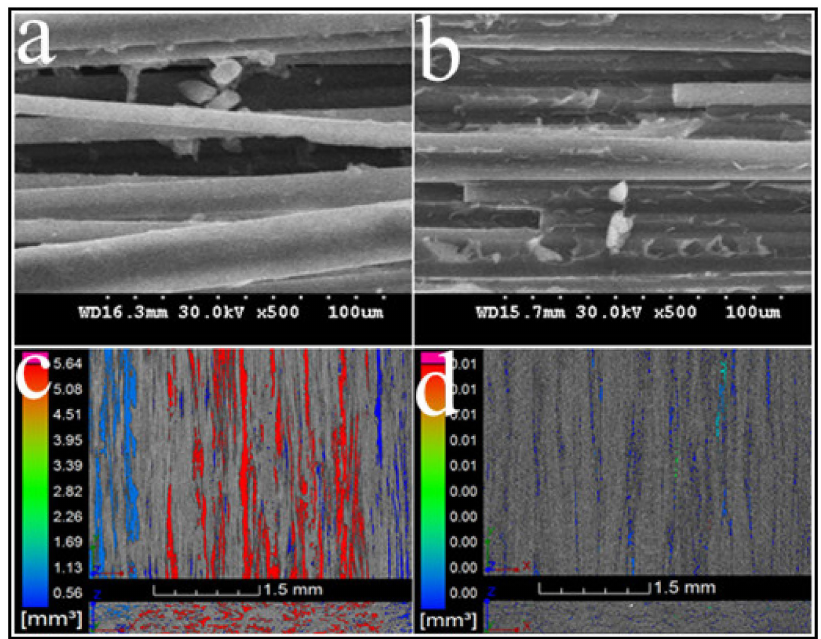
Figure 11. Fiber–resin interface and internal voids of the ( a , c ) pre-formed and ( b , d ) cured samples,